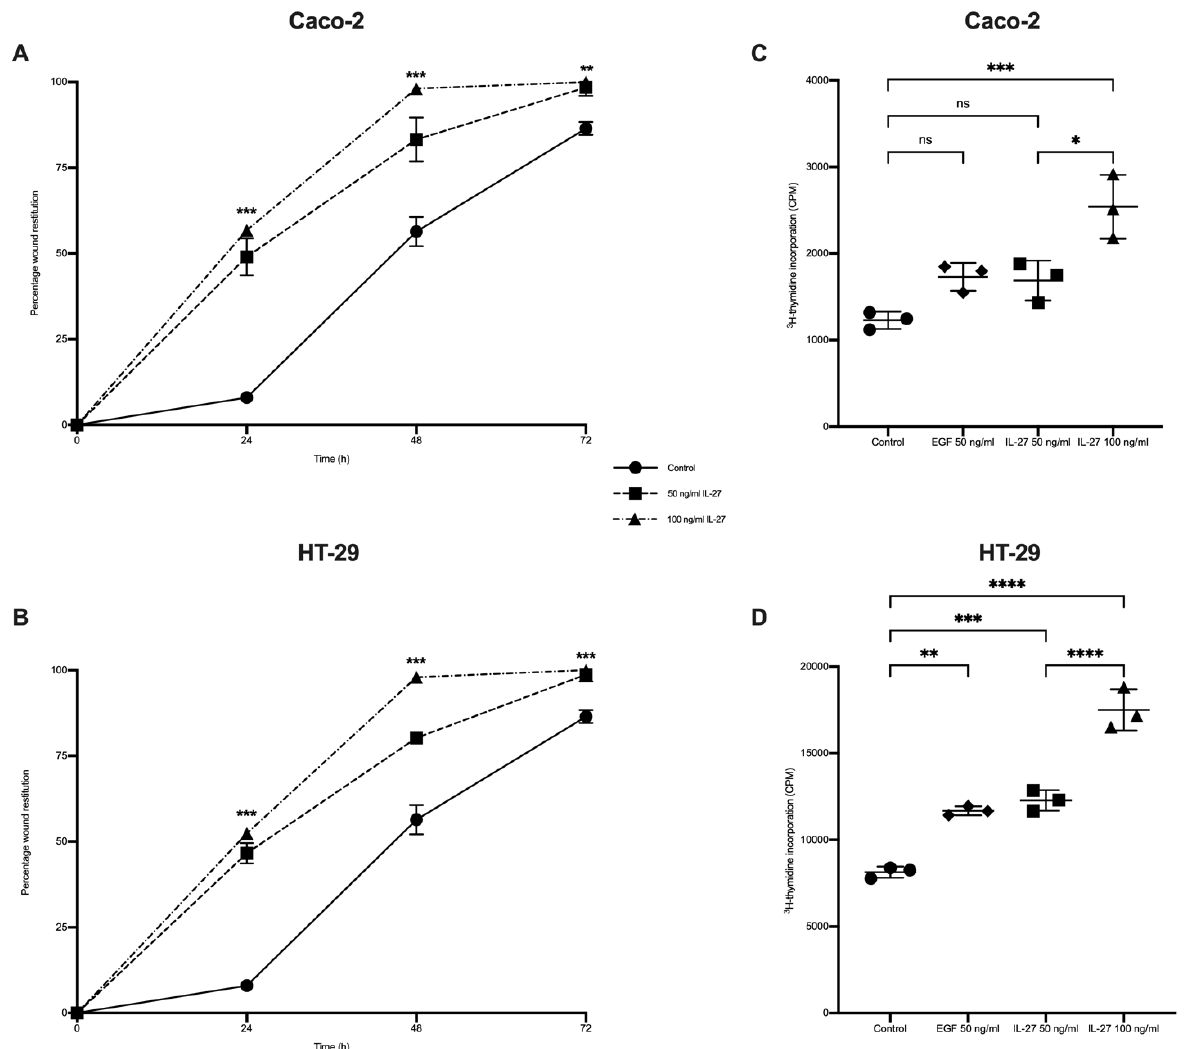
Figure 5. IL-27 effect on gastrointestinal epithelial wound restitution and proliferation. Colonicepi- thelial cell lines Caco-2 and HT-29 stimulated with 50 and 100 ng/mL IL-27 and growth dynamics were determined in comparison with unstimulated controls by ( A , B ) scratch wound assay and ( C , D ) 3 H-thymidine incorporation assessing cell proliferation. Epithelial growth factor (EGF) was positive control. n = 3 experimental replicates, each performed in triplicate; data presented as mean ± SD. Statistical analysis with Kruskal–Wallis test ( A , B ) and one-way ANOVA with Bonfer- roni test ( C , D ). * p < 0.05, ** p < 0.01, *** p < 0.001 and **** p < 0.0001; ns = not significant.